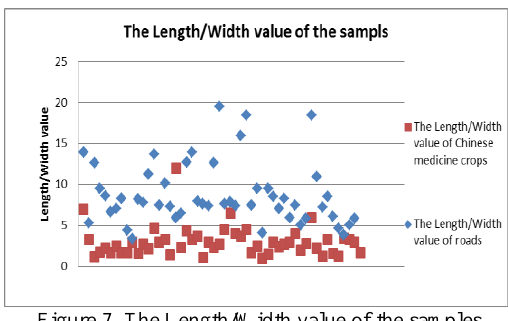
Figure 7. The Length/Width value of the